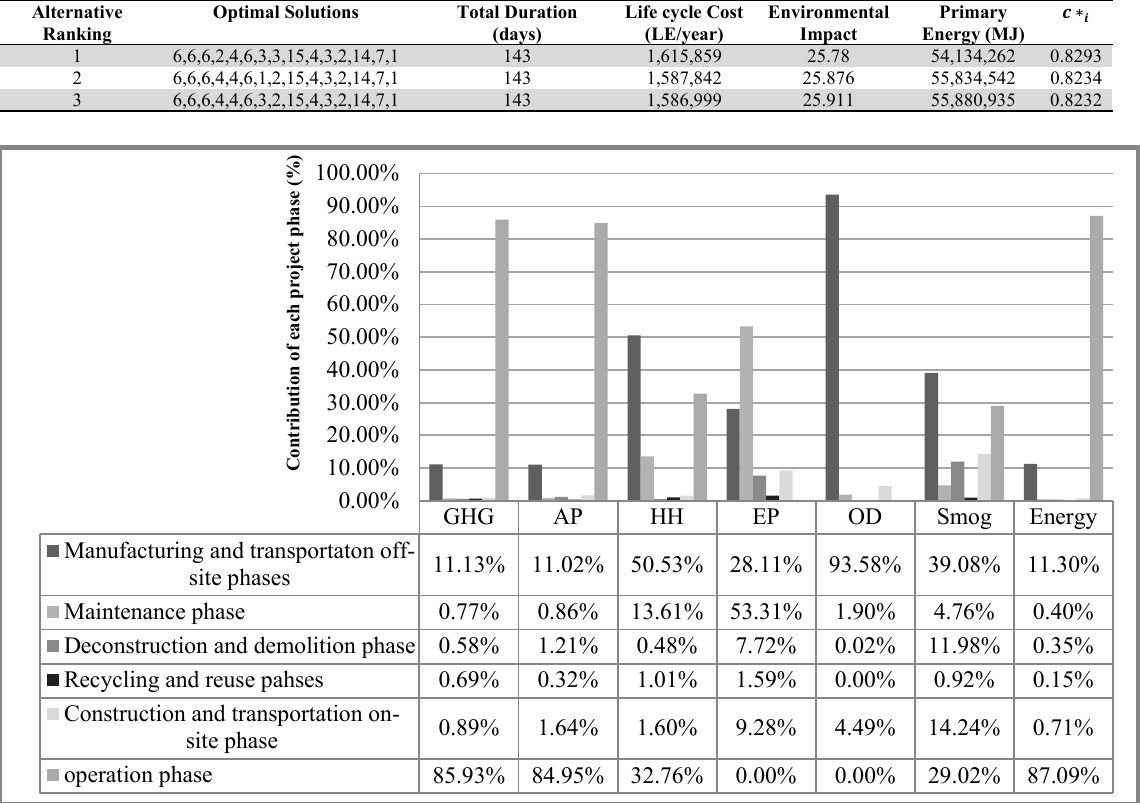
Description of the best three solutions obtained from TOPSIS